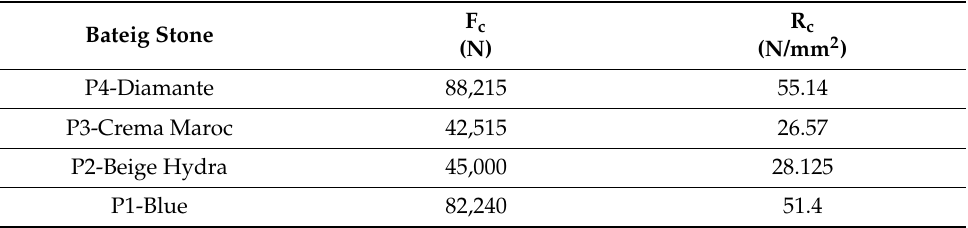
Table 10. Compressive strength test: Bateig stone specimens treated with MYXOSTONE M3P (mean